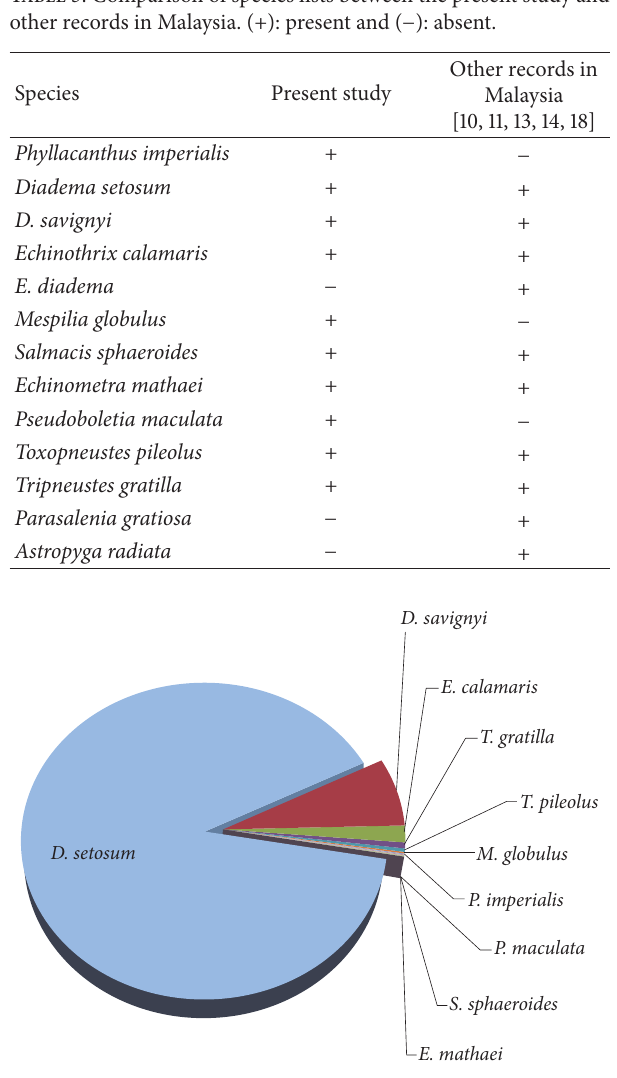
Figure 2: Species composition of sea urchins found in Sabah